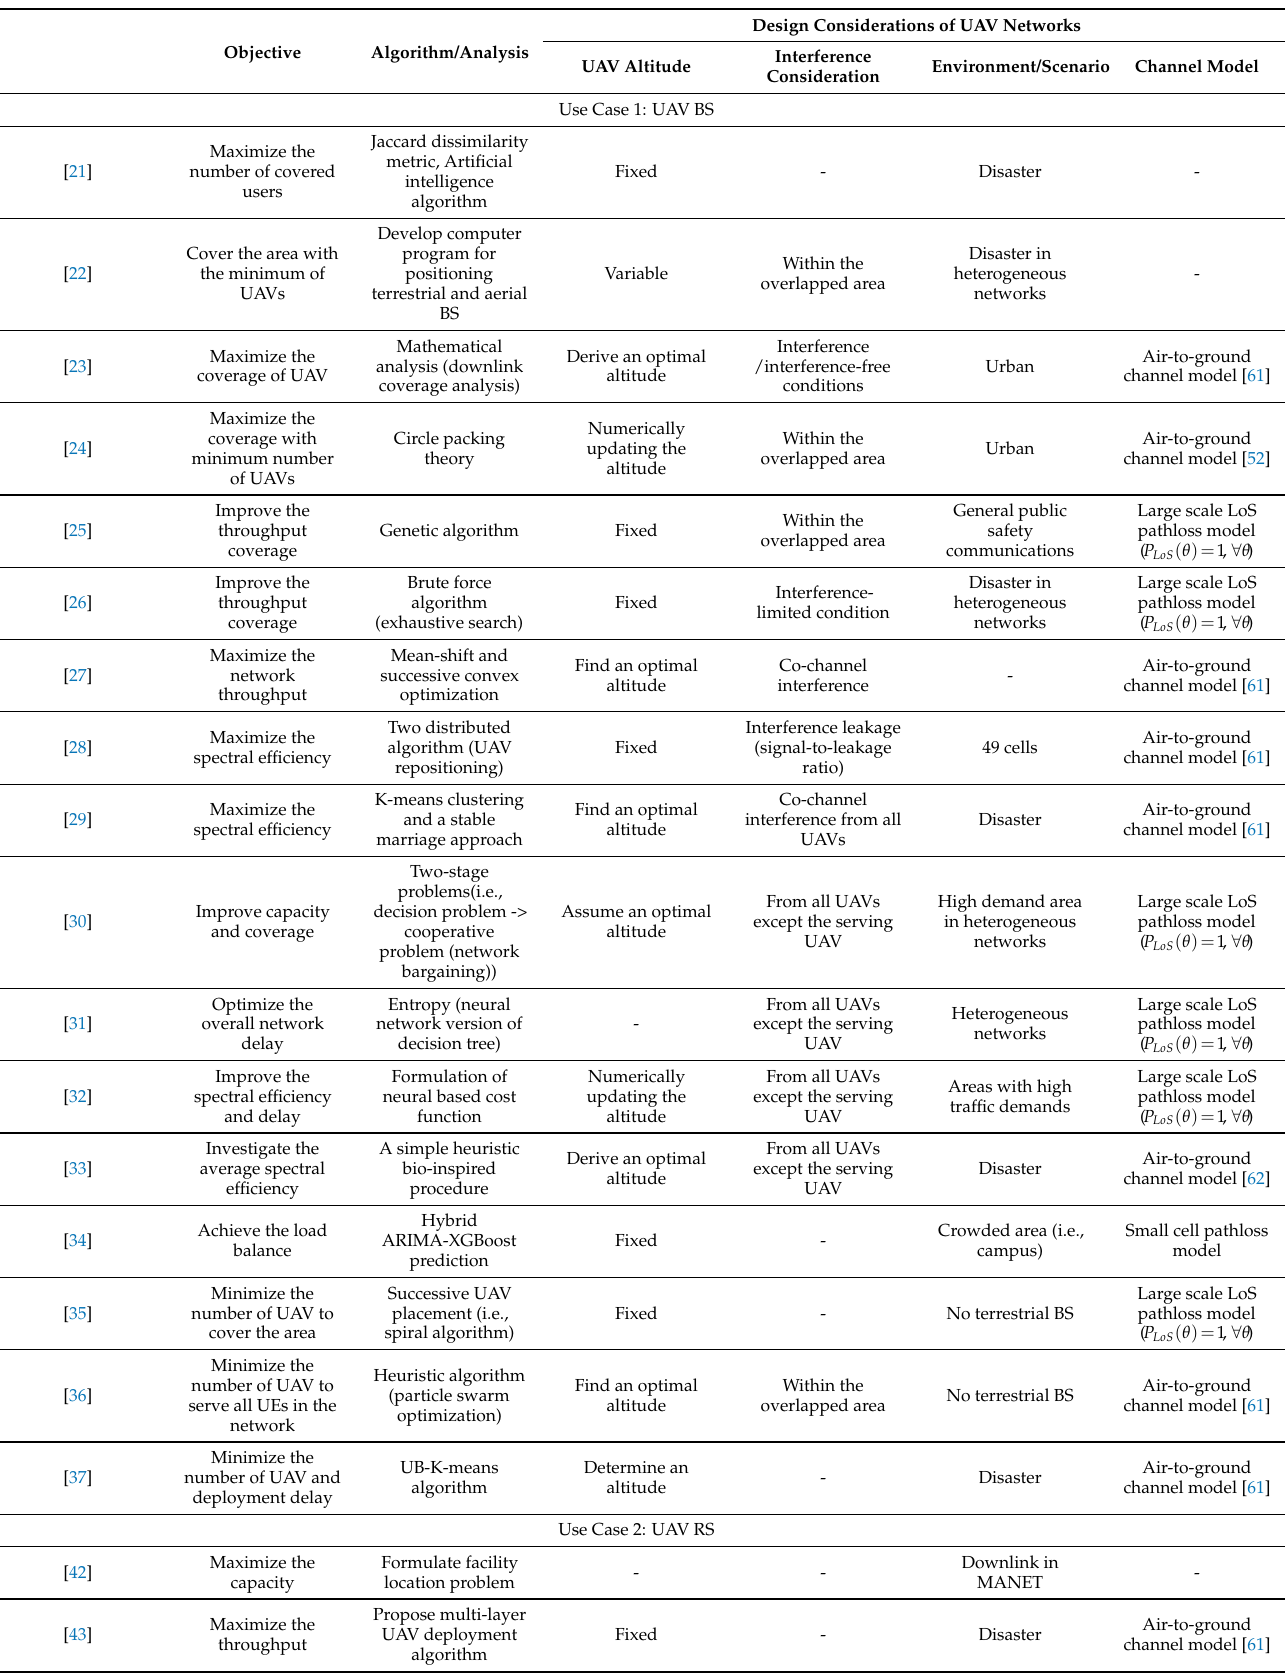
Table 1. Deployment of multiple